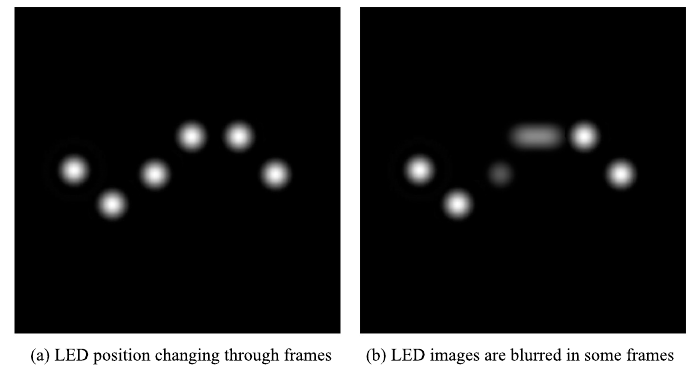
Figure 9. Image after random walk and motion blur model are applied.